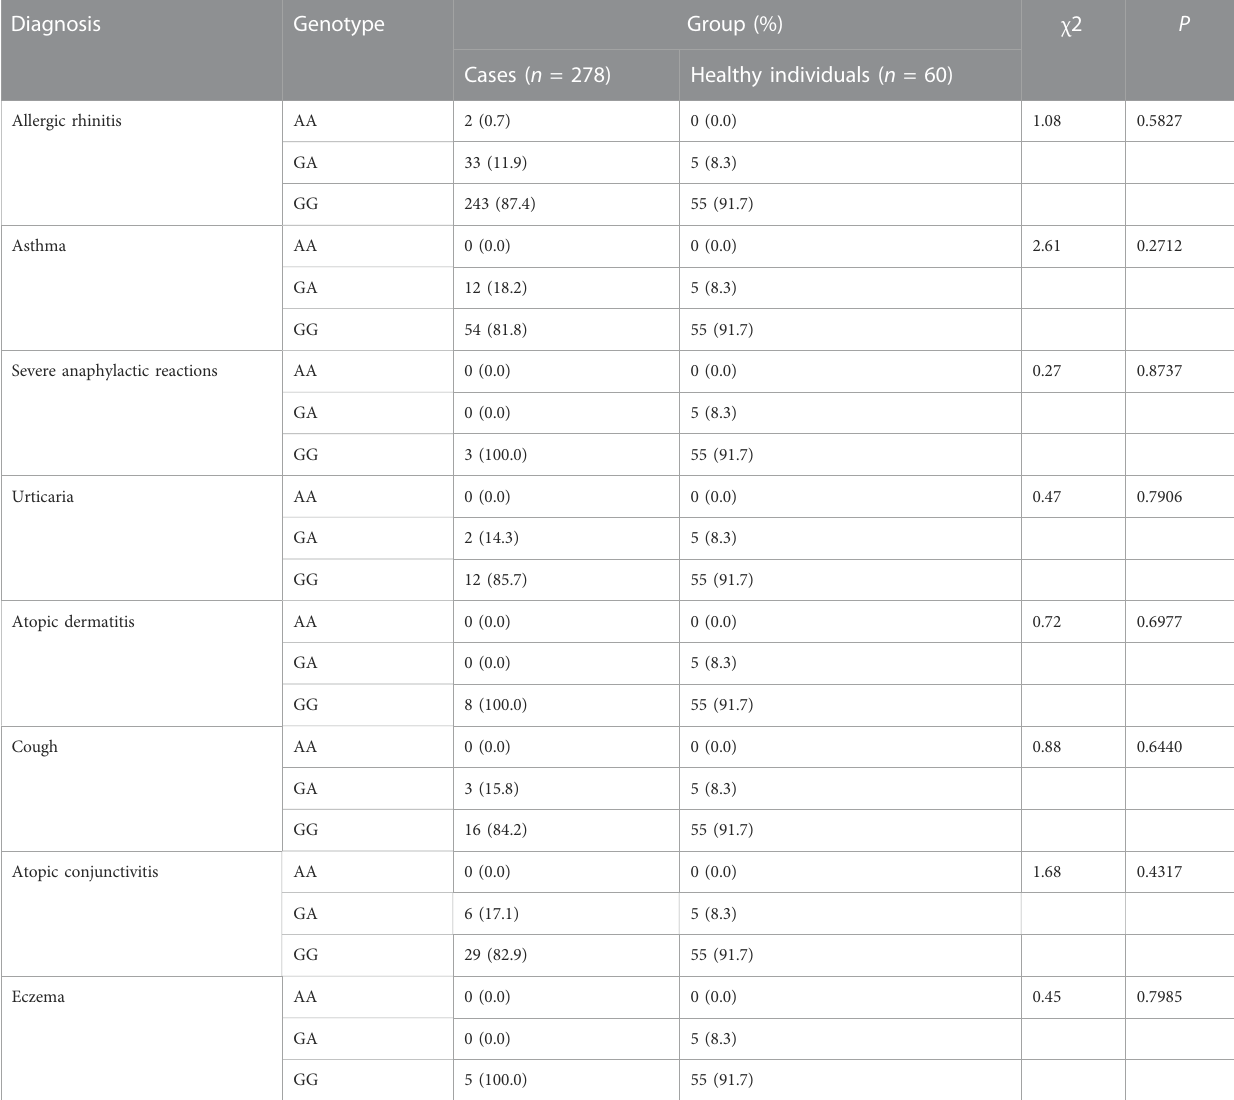
TABLE 8 Analysis of Association of TNF- α rs1800629 ( − 308 G > A) with Genetic Susceptibility to